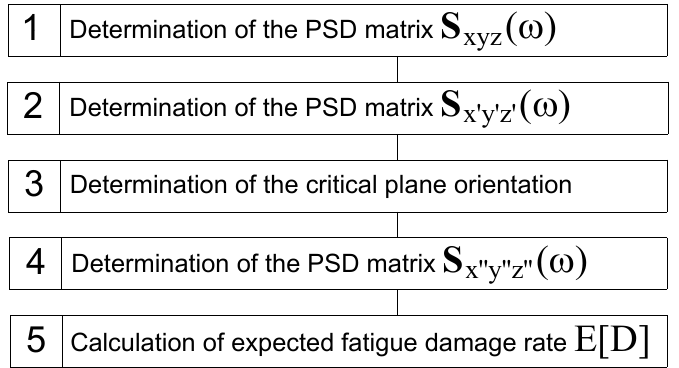
Figure 1: Algorithm for damage determination using the F-D/CP